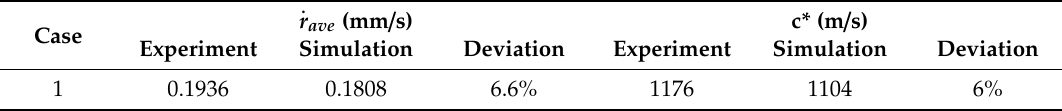
Table 4. The characteristic velocities and average regression rate that obtained from numerical and experimental result.